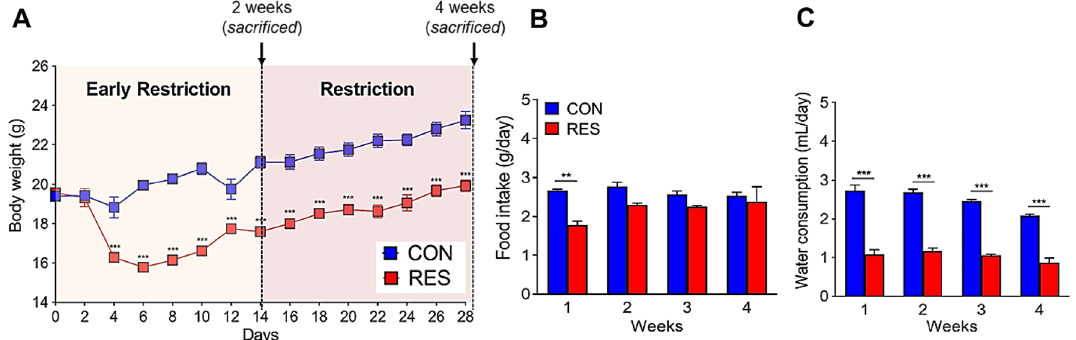
Figure 1. Effects of prolonged dehydration in mice. Changes in ( A ) body weight, ( B ) food intake, and ( C ) water consumption in hydrated (CON) and restricted (RES) mice (n = 10 mice/group). Data are expressed as